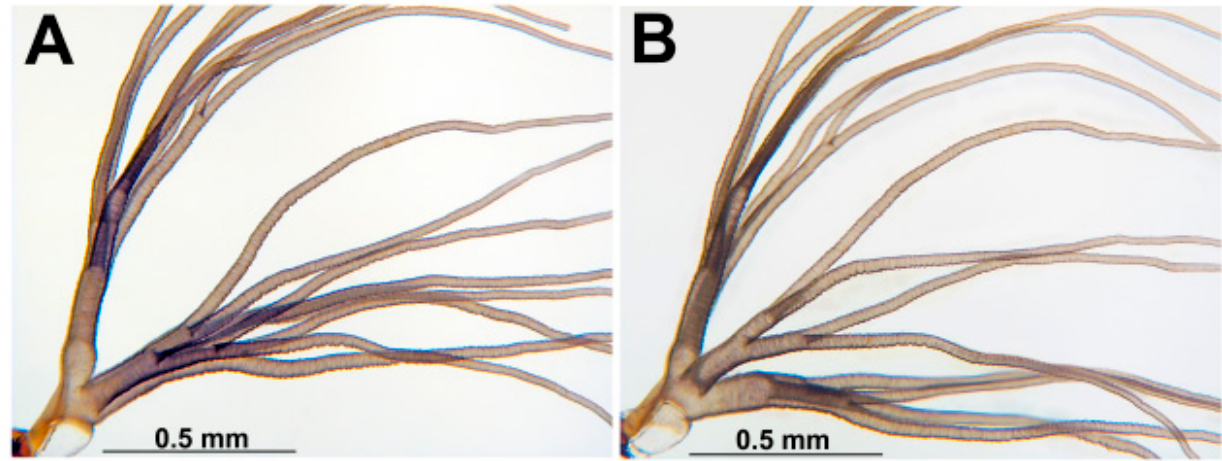
Figure 7. Pupal gill of Prosimulium supernum n. sp. ( A , B ) Lateral views with slight differences in orientation; apices of filaments not shown.